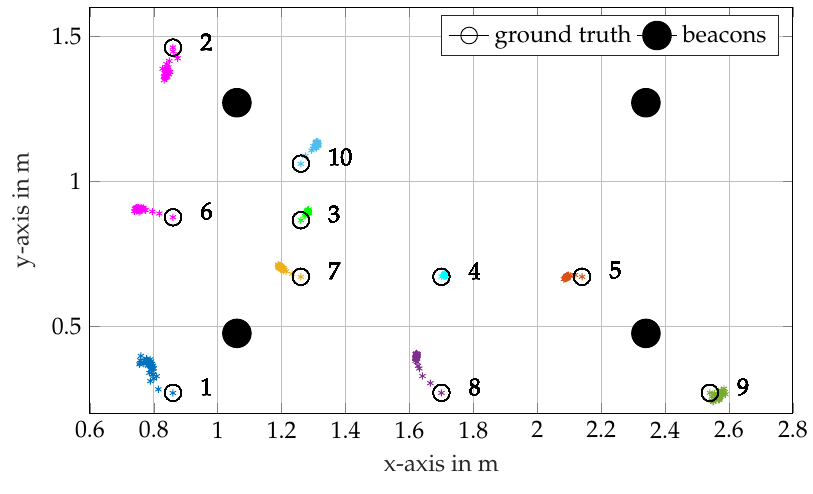
Figure 17. Static receiver self-localization at ten different positions. A PF with 1,000 particles merges the measurements.